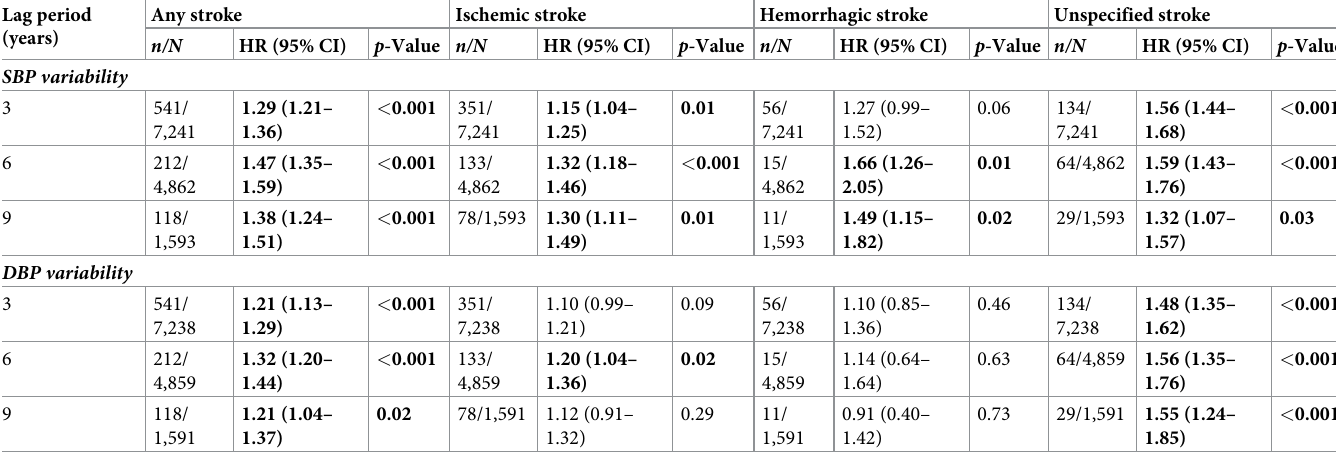
The estimates represent the HR of incident stroke per standard deviation increase of systolic or diastolic blood pressure variability AU : InthefirstsentenceofthelegendofTable 3 : Ichangedsystolicbloodpressurevariabilitytosystolicordiastolicbloodpressurevariability : Ifthisnotcorrect ; pleaseeditasnecessary : . Values in bold are statistically significant. Adjusted for age, sex, mean SBP or DBP, and propensity score. CI, confidence interval; DBP, diastolic blood pressure; HR, hazard ratio; n , number of participants with incident stroke; N , total number of participants at risk; SBP, systolic blood